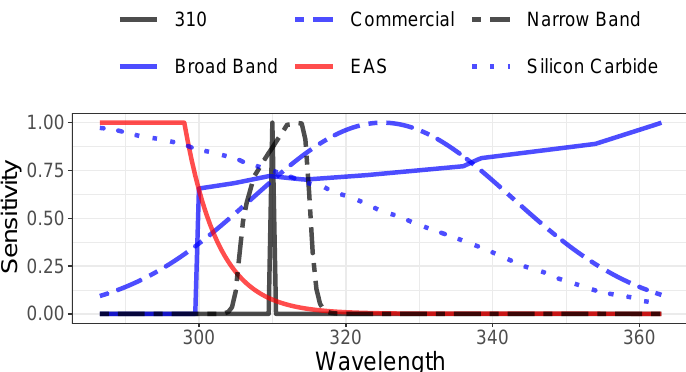
Figure 4. Spectral sensitivity curves of the filters modeled in Table 1. The theoretical ideal is the erythema action spectrum (red), 310 nm designs (black) include a narrow band and a more practical narrow band pass. Other UV-sensitive designs (blue) include broad band detection, silicon carbide, and a detector commercially marketed for estimating